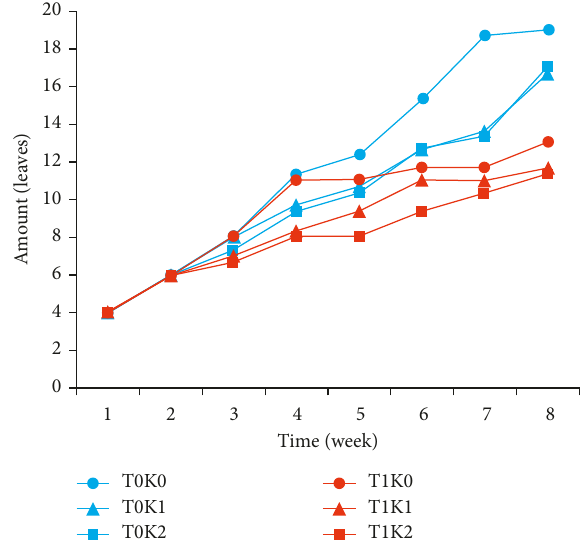
Figure 4: Graph of the average growth of leaves amount.